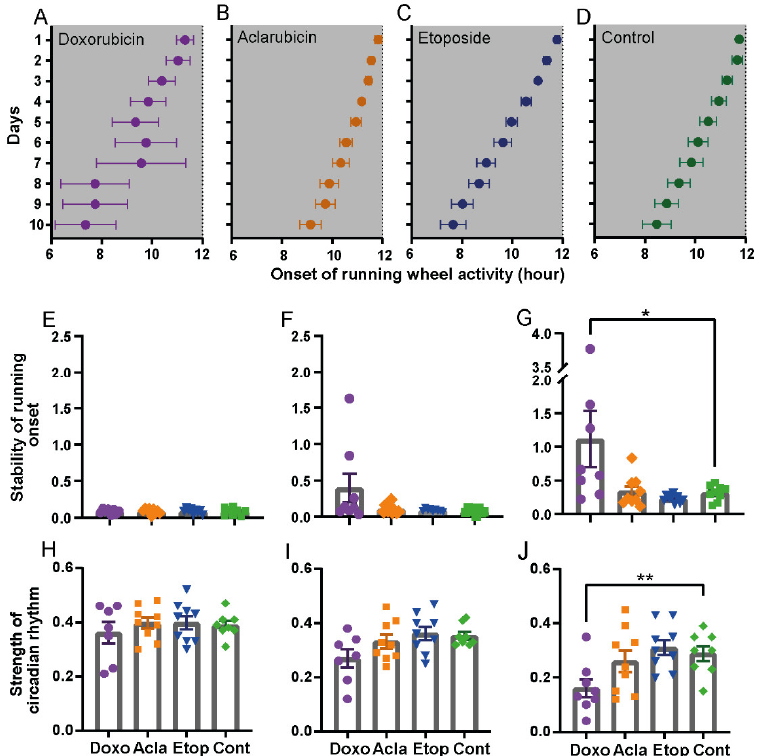
Figure 4. Doxorubicin-treated mice show a disrupted circadian clock. ( A – D ) Average wheel-running activity onset time of doxorubicin ( A ), aclarubicin ( B ), etoposide ( C ), and control ( D ) treated mice over a period of 10 days. Grey areas indicate the period of darkness. E and F . Average 10 days stability of running onset time under baseline condition ( E ), treatment LD condition ( F ), and treat- ment DD condition ( G ). ( H – J) Strength of the circadian rhythm (Qp) of wheel-running activity un- der baseline condition ( H ), treatment LD condition ( I ), and treatment DD condition ( J ). Data are shown as mean ± SEM. doxorubicin n = 8, all other treatments n = 9 per group. One-way ANOVA with Bonferroni multiple comparison; * p < 0.05, ** p < 0.01. Overall, the data show that the present mouse model of CRF can discriminate be- tween different working mechanisms of cancer treatment drugs. In addition, sleep is not affected by treatment with the drug that causes fatigue. In contrast, therapy-induced CRF is likely caused by alterations in the central circadian pacemaker as circadian rest-activity behavior shows less precise timing and has a reduced rhythm strength in mice treated with doxorubicin.